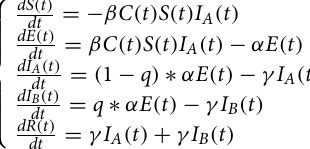
S(t) : The number of susceptible people in Guangzhou. E(t) : The number of exposed people in Guangzhou. I A (t) : The number of active infections (without quarantine/isolation). I B (t) : The number of quarantined/isolated infections. R(t) : The number of the recovery in Guangzhou. N : The total population in Guangzhou. V : The number of people who were fully vaccinated (2 doses) before the outbreak in Guangzhou. e : Vaccine efficacy for preventing infection. L : the mean latent period for the disease. α : The rate of transmission for the exposed to be infected, which is equal to 1/L. β : The rate of transmission via contact with active infections. C(t) : Average contact rate per active infectious person. t c : Mean time from onset to becoming infectious. q : The quarantine/ isolation effect (1/ t c ). D : Mean infectious period. γ : The rate of recovery, which is equal to 1/D. S 0 : The initial number of susceptible people in Guangzhou is N − E 0 − I 0 − R 0 − V ∗ e . E 0 : The initial number of exposed people in Guangzhou. I 0 : The initial number of infectious people in Guangzhou. R 0 : The initial number of recovered people in Guangzhou.